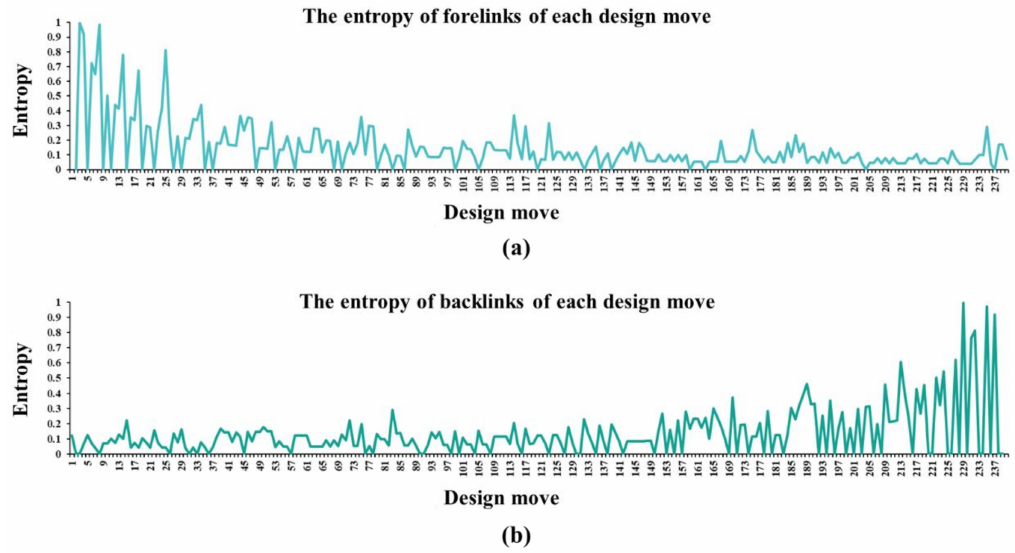
Figure 5. ( a ) The entropy of forelinks of each design move ( b ) The entropy of backlinks of each design